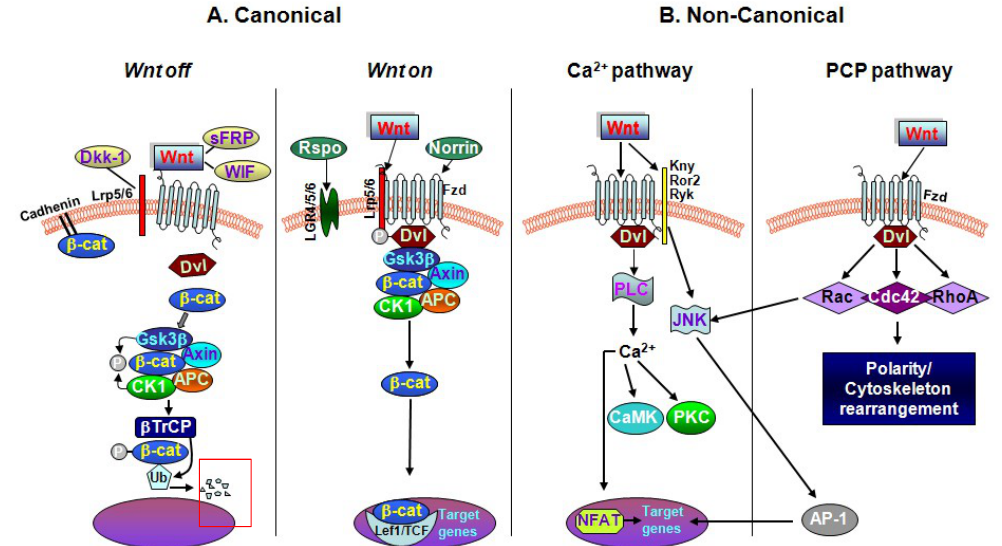
Figure 1. Schematic representation of canonical Wingless-type mouse mammary tumor virus (MMTV) integration site (Wnt) pathway and non-canonical Wnt/Ca 2+ and Wnt/planar cell polarity (PCP) pathways [38–43]. ( A ) In the Wnt off state (i.e., in the absence of a Wnt ligand), cytoplasmic β -catenin is constantly degraded by the action of the Axin complex. Casein kinase 1 (CK1) and glycogen synthase kinase 3 β (GSK-3 β ) sequentially phosphorylate the amino terminal region of β -catenin, resulting in β -catenin ubiquitination and proteasomal degradation (red box). In the Wnt on state, canonical Wnt/ β -catenin pathway activation starts with Wnt binding Frizzled (Fzd) receptor and the co-receptor low-density lipoprotein receptor-related protein 5/6 (LRP5/6), which induces the recruitment of Dishevelled (Dvl) leading to the inhibition of the β -catenin destruction complex formed by Axin, adenomatous polyposis coli (APC), GSK-3 β , and CK1. This inhibition causes the accumulation of β -catenin, which is no longer phosphorylated by the destruction complex. β -catenin then translocates to the nucleus where it activates transcription of Wnt target genes. ( B ) In the non-canonical Wnt/Ca 2+ pathway, the binding of Wnt to Fzd activates the heterotrimeric G-proteins. These signal through phospholipase C (PLC) and inositol 1,4,5-triphosphate (IP3) to induce the release of intracellular Ca 2+ and the activation of protein kinase C (PKC) and Ca 2+ /calmodulin-dependent protein kinase II (CaMKII). Multiple interactions are possible between the targets of the Wnt/Ca 2+ and the canonical Wnt/ β -catenin pathway at different points. Additionally, Kny, Ror2, or Ryk receptors with Fzd receptors can activate c-Jun N-terminal kinase (JNK), promoting target gene expression through activator protein 1 (AP-1). In non-canonical Wnt/PCP pathway, Wnt proteins bind to Fzd, which activates small guanosine triphosphatases (GTPases) proteins Rho and Rac and c-Jun N-terminal kinase via Dvl. This interaction results in cytoskeletal regulation and involves polarized cell shape changes and cytoskeleton